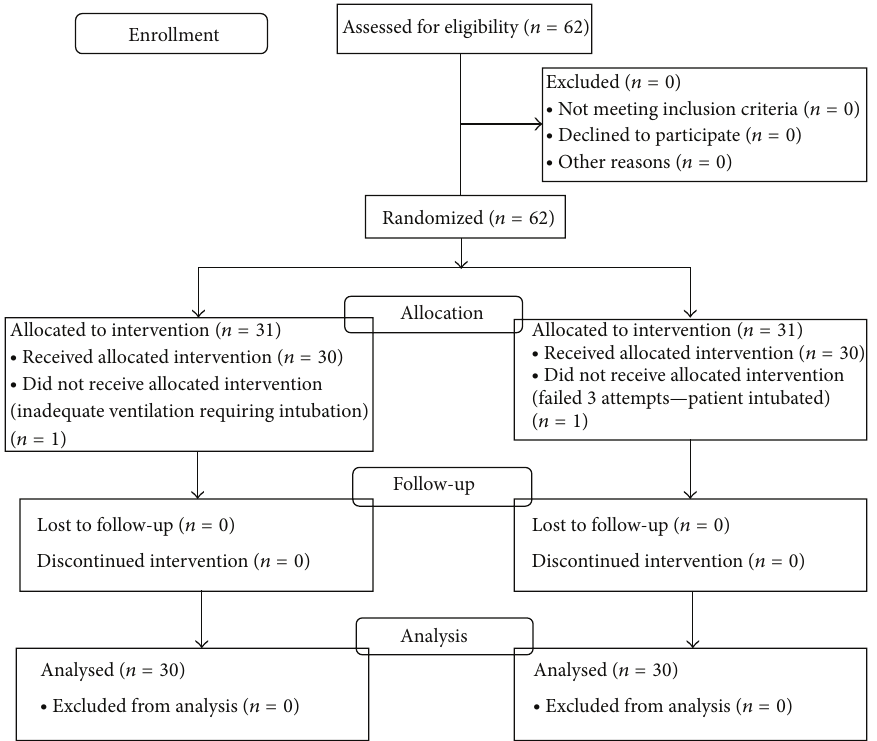
Figure 1: CONSORT figure representing enrolment data.